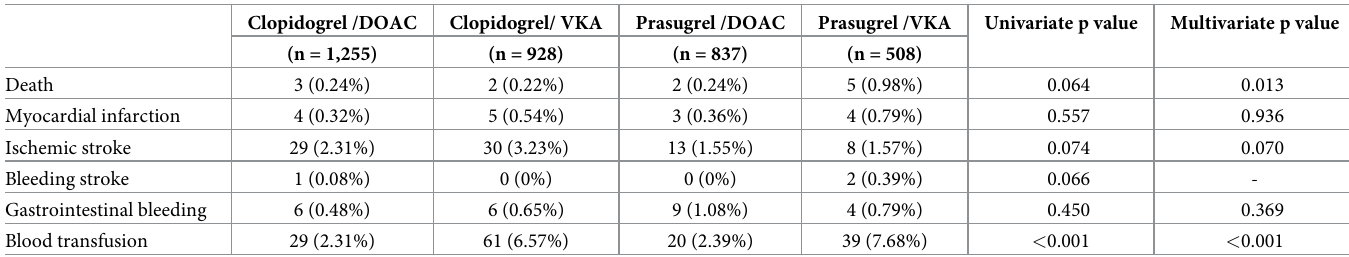
Table 3. Clinical events in non-AMI